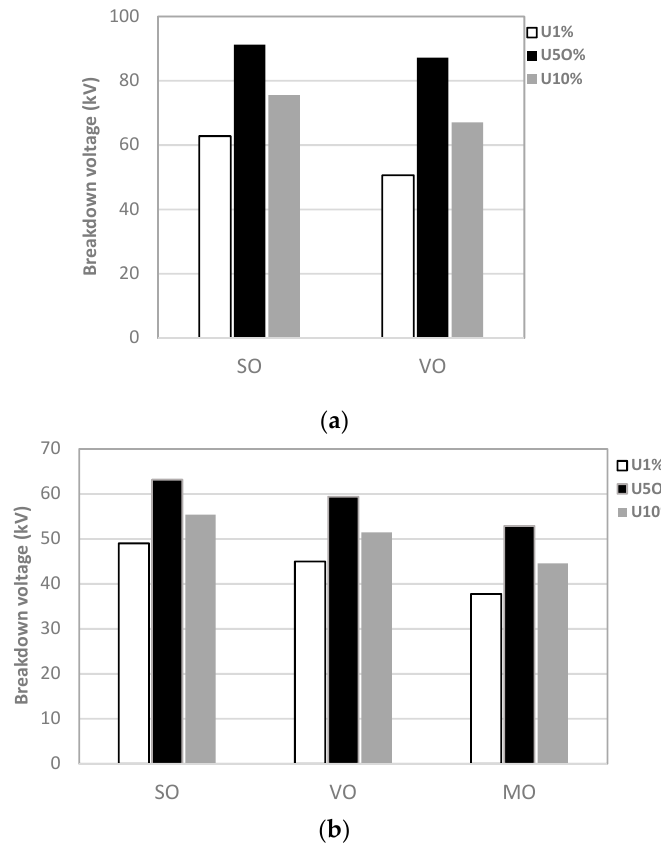
Figure 9. Probability of AC ( a ) and DC ( b ) breakdown voltages of oils alone.